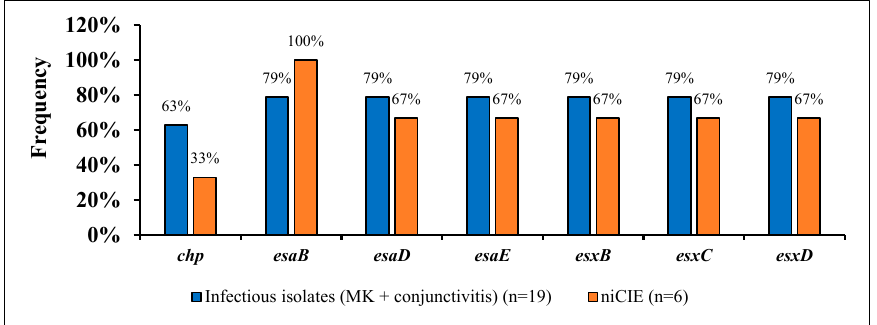
Figure 3. Possession of 7 virulence genes involved in immune evasion and type VII secretion system in S. aureus by disease group.